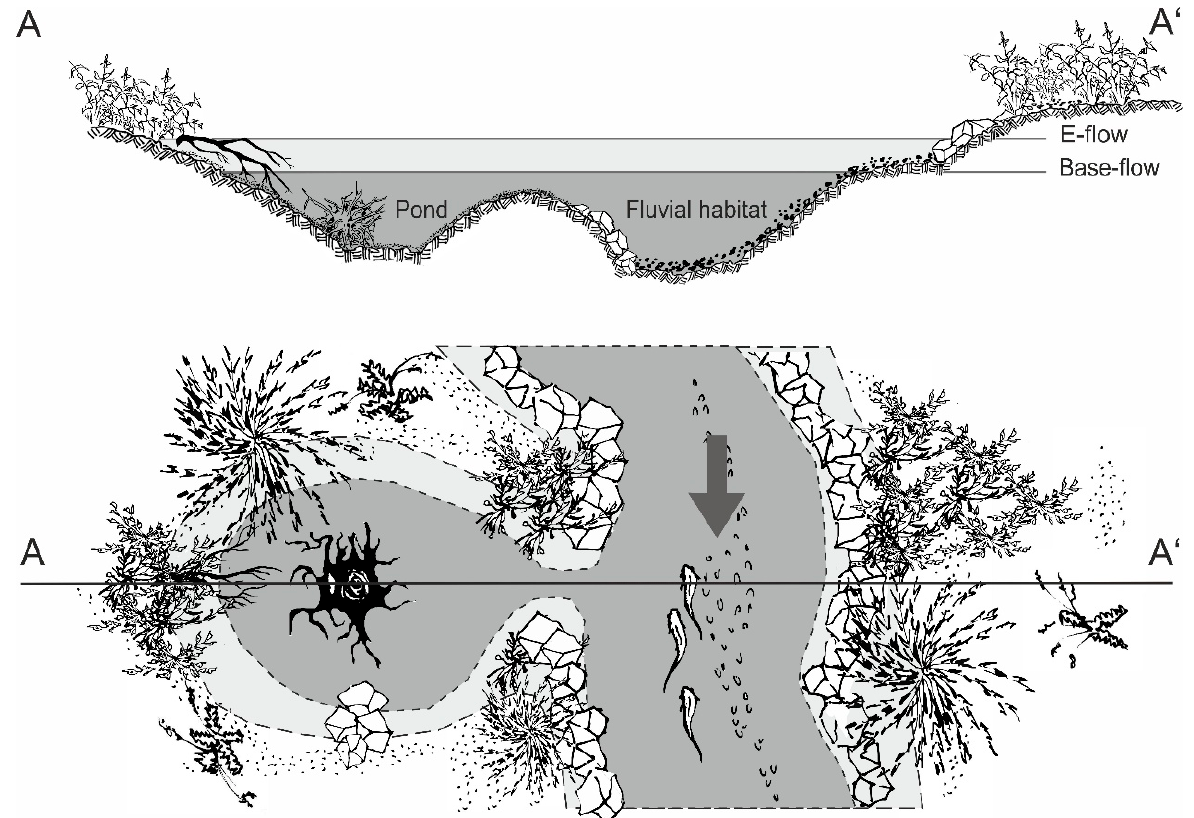
Figure 3. Schematic drawing (cross section and top-view) of the principle habitat types fluvial habitats and ponds, which were assessed in this study. Base-flow line indicates the water level at base-flow conditions (900 L s − 1 ). E-flow line indicates water level during the application of environmental flows (additionally to the base-flow another 900 L s − 1 discharge can be provided in the fish pass). Note that e-flow conditions can only be applied in the fish pass Gars.